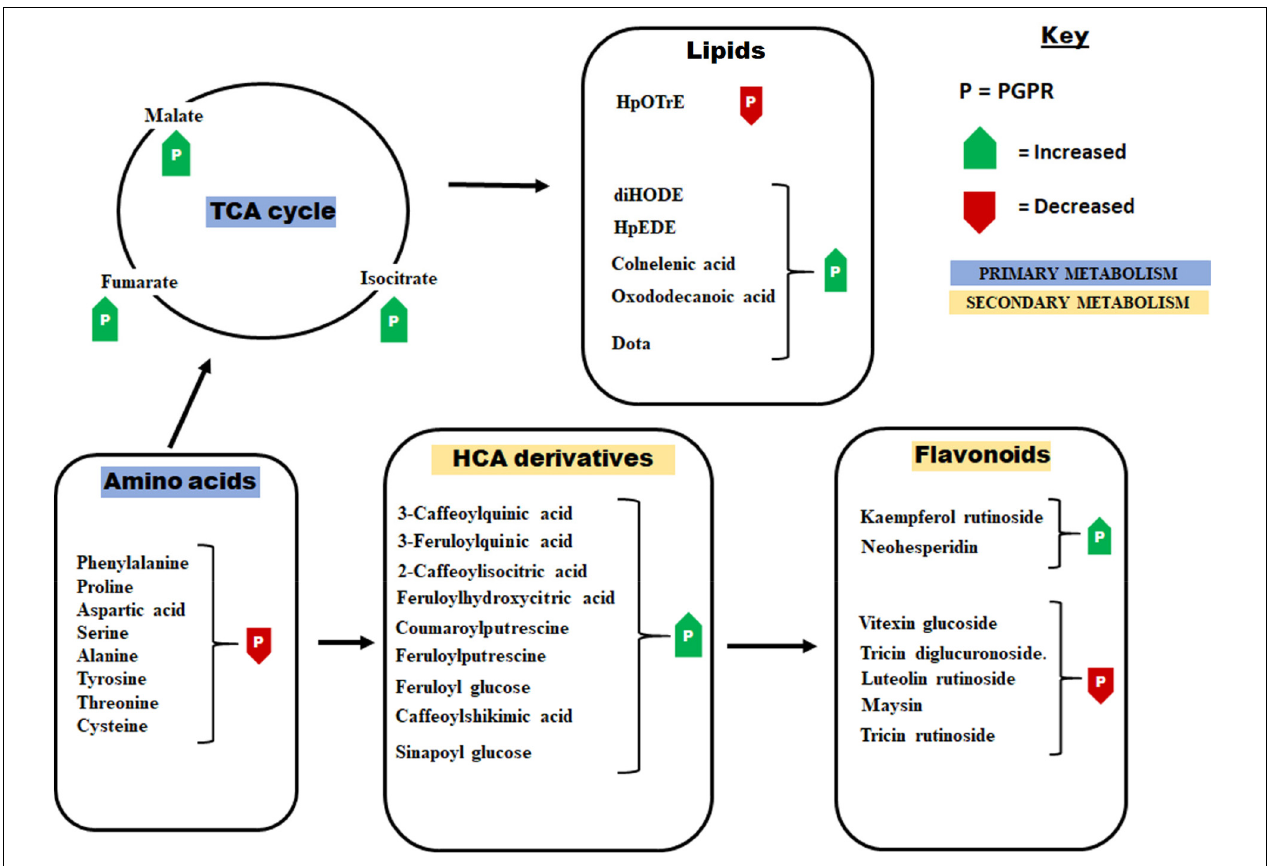
FIGURE 3 | Some of the principal pathways and metabolites that showed differential changes in response to the application of the PGPR-based biostimulant. The PGPR treatment has been shown to induce metabolic readjustment in both primary and secondary metabolism. These metabolic changes were associated with enhanced plant growth and the establishment of a “sensitized” or “ready-to-go” state. HpOTrE, hydroperoxy-octadecatrienoic acid; HpEDE, hydroperoxy-eicosadienoic acid; DiHODE, dihydroxy-octadecadienoate; Dota, dihydroxy-octadecatrienoic acid.